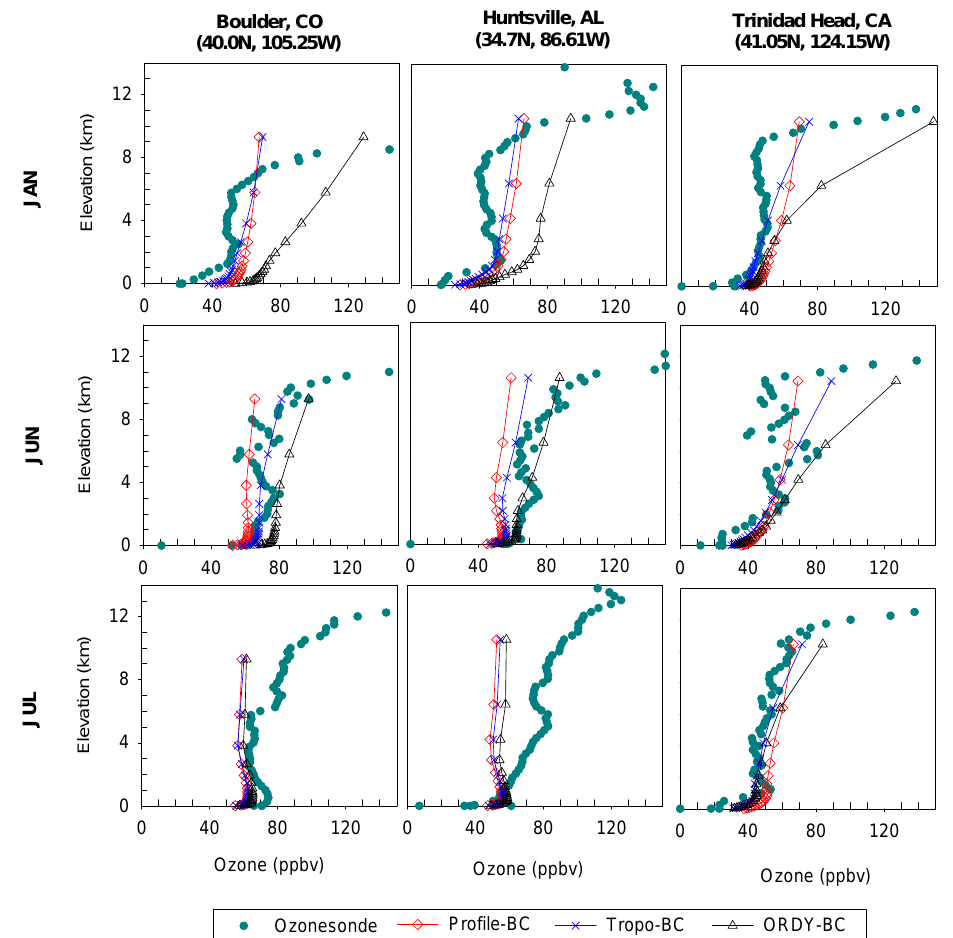
Fig. 8. CMAQ simulated monthly vertical distribution of ozone for Profile-BC (red line), Tropo-BC (blue line) and ORDY-BC (black line) with ozonesonde.